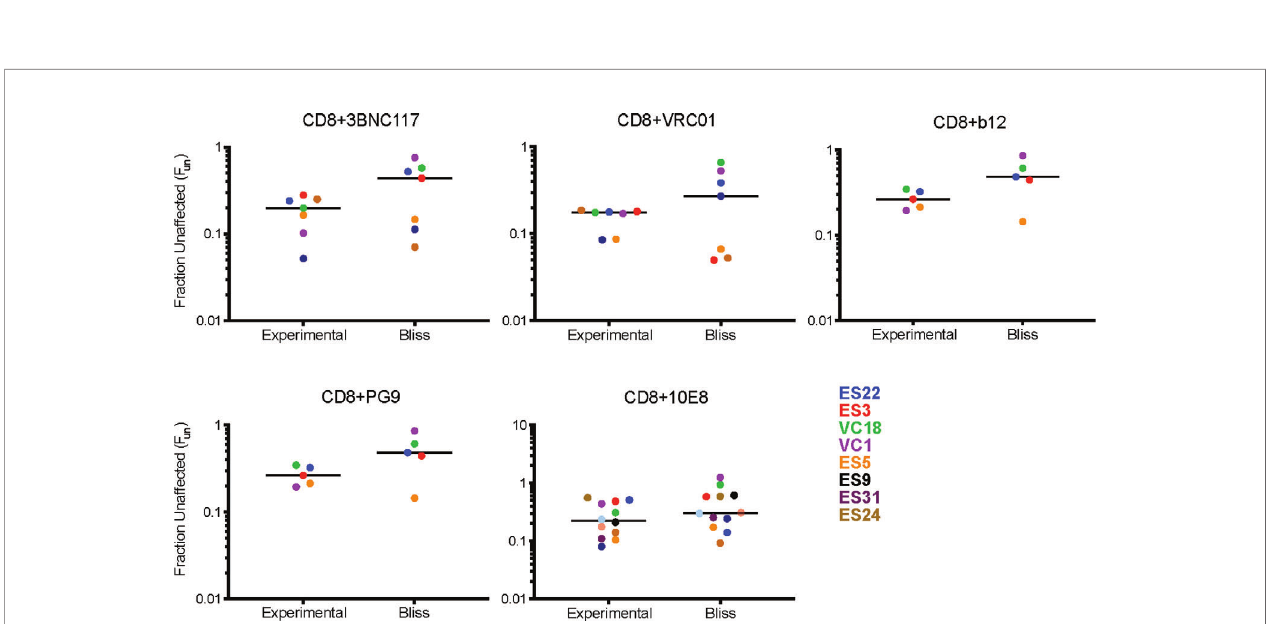
FIGURE 4 | Individual bNAbs and CD8 T cells act independently to suppress HIV replication. Experimental F un values from each individual bNAb were compared to the predicated Bliss F un values. Each BLISS or Fun data point is calculated from the average of three technical replicates performed for each condition. The line indicates median and each point indicates an independent experiment or predicated value, one color per subject. Statistical analysis was performed using paired t tests.